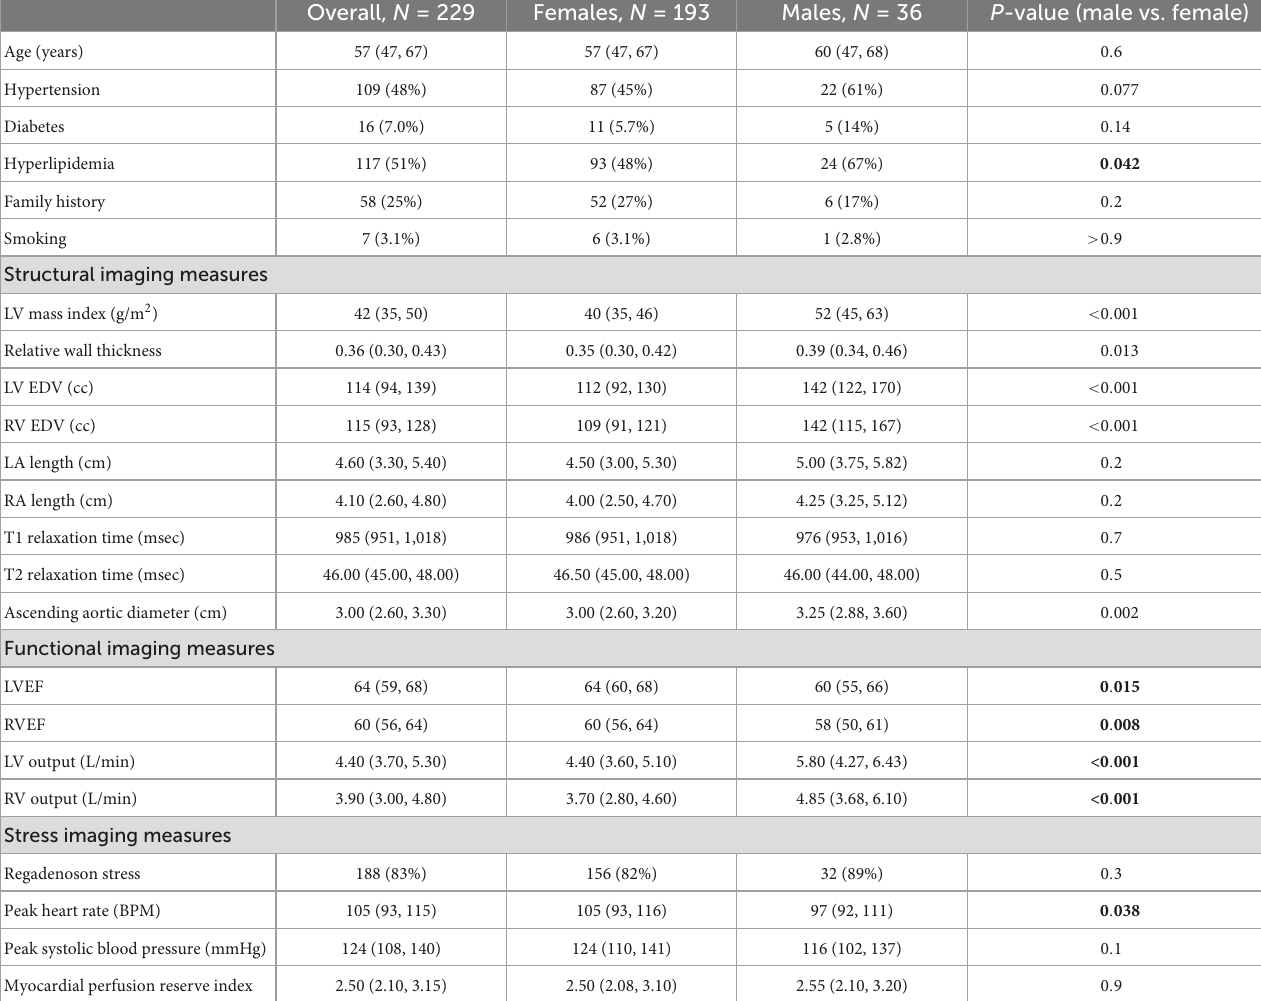
TABLE 1 Demographic, traditional risk factors, and cardiac imaging characteristics overall and by sex. Overall, N = 229 Females, N = 193 Males, N = 36 P -value (male vs. female)